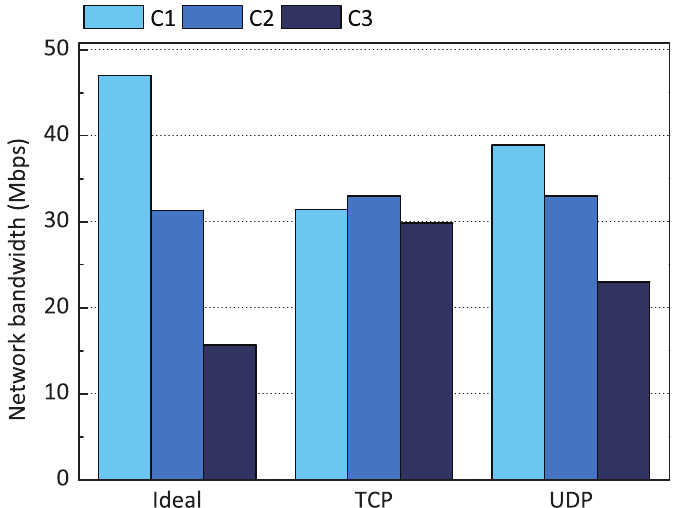
Figure 3. Performance of Deficit Round-Robin in Linux Traffic Control when the weights of three containers are 3:2:1, and each container sends TCP ( left ) and UDP packets ( right